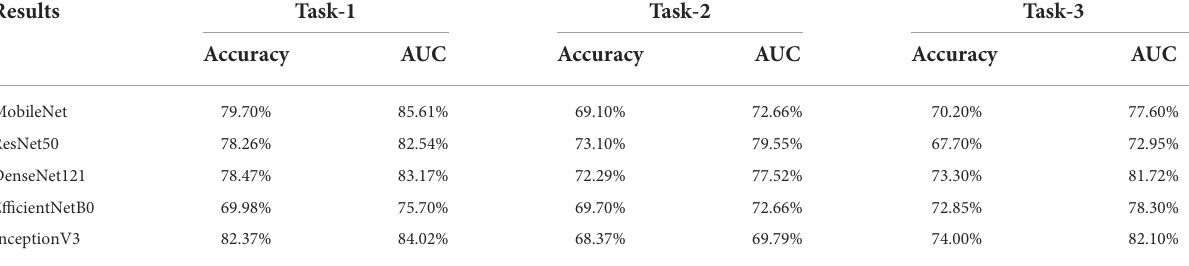
TABLE 2 Five models’ prediction results of three tasks at the image level.